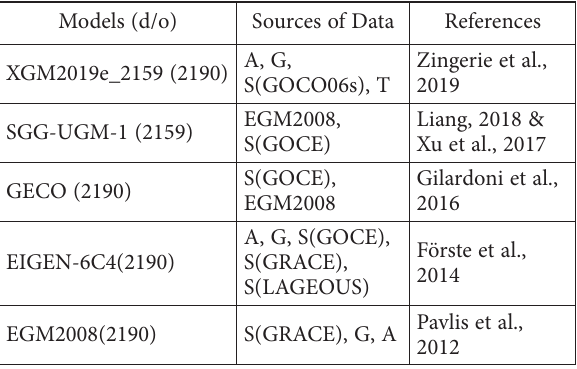
Table 1. Summary of the five combined GGMs used in this